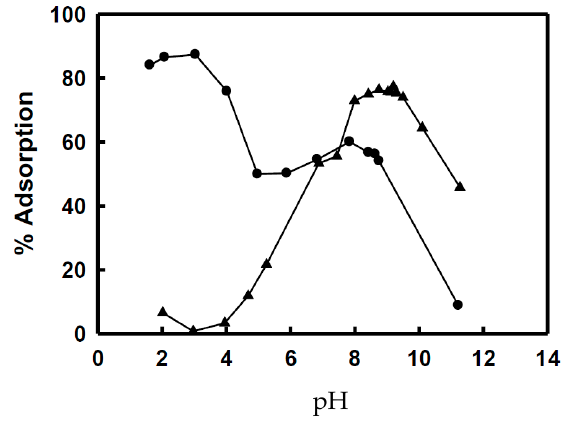
Figure 33. % adsorption of As(III and V) ions by Fe(III)-loaded Laminaria japonica gel crosslinked with epichlorohydrin at different pH values at equilibrium. ● As(V), ▲ :